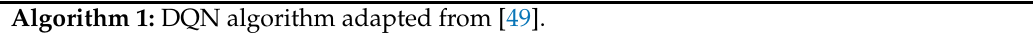
Algorithm 1: DQN algorithm adapted from [49].